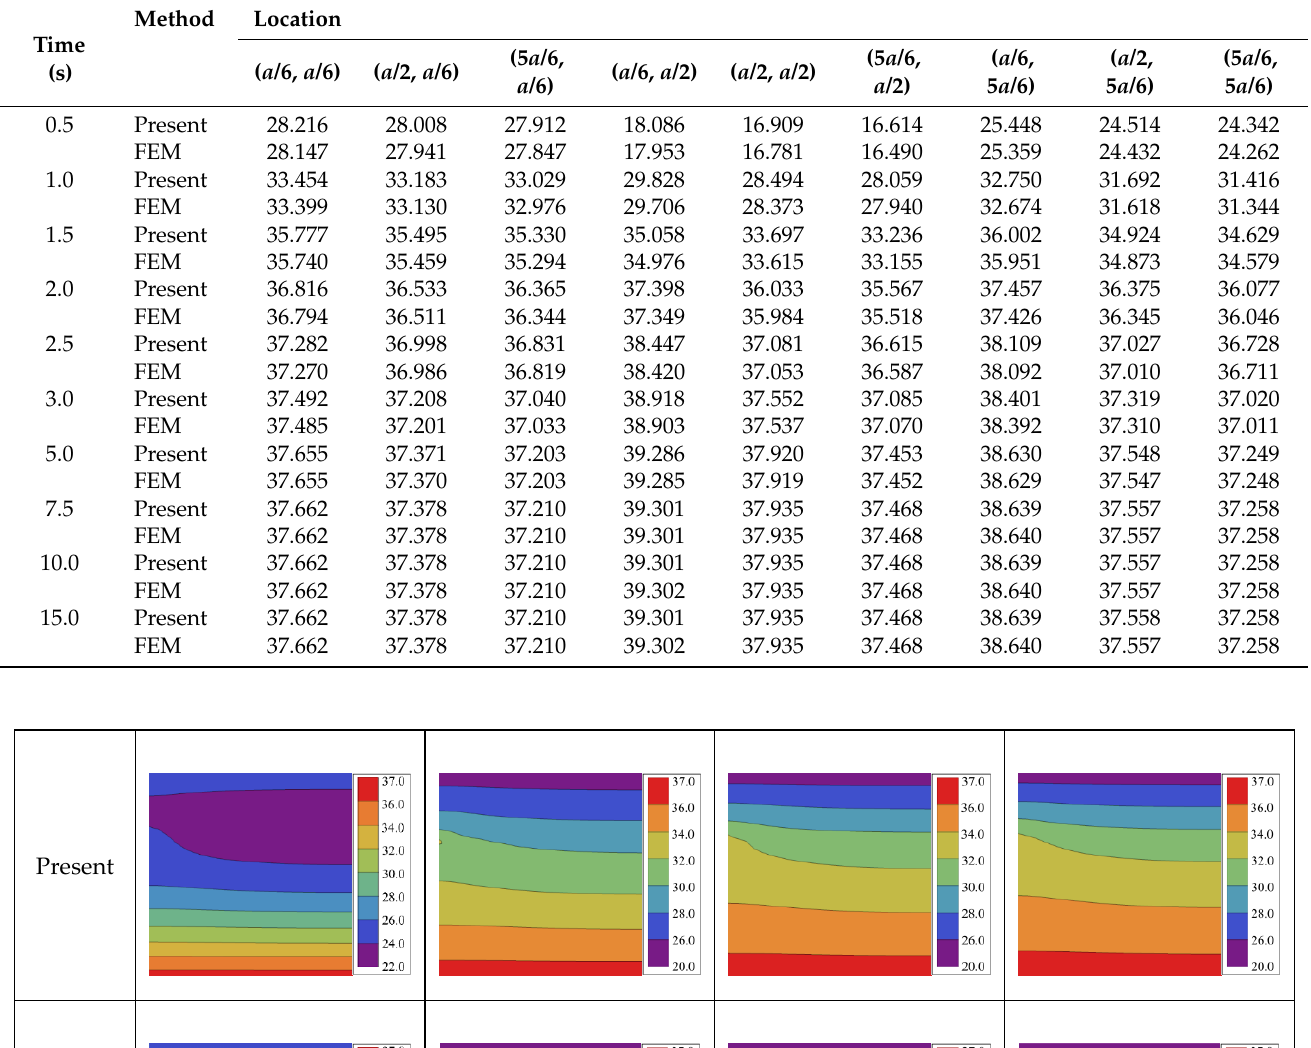
Table 3. FEM-validated temperature solutions ( ◦ C) at different times for Case 2.